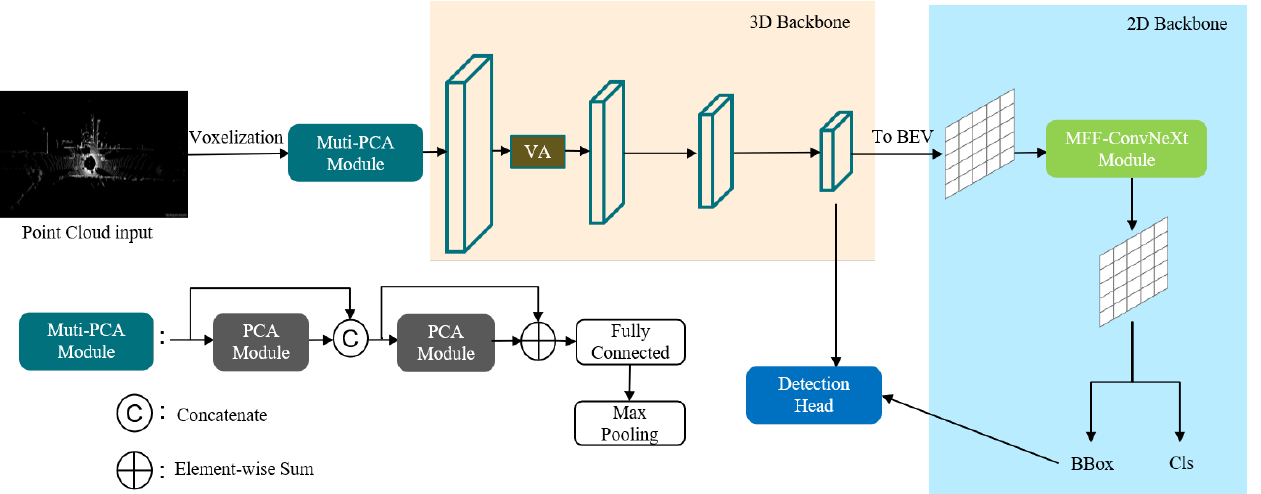
Figure 1. The structure of Voxel R-CNN network with multi-attention module and MFF- ConvNeXt